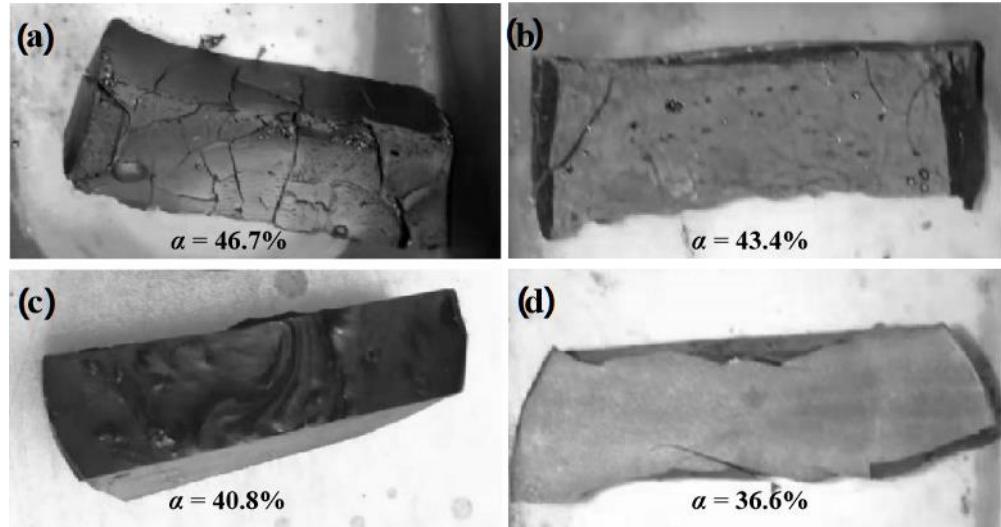
Figure 2. Morphology of sintered samples with different α values.